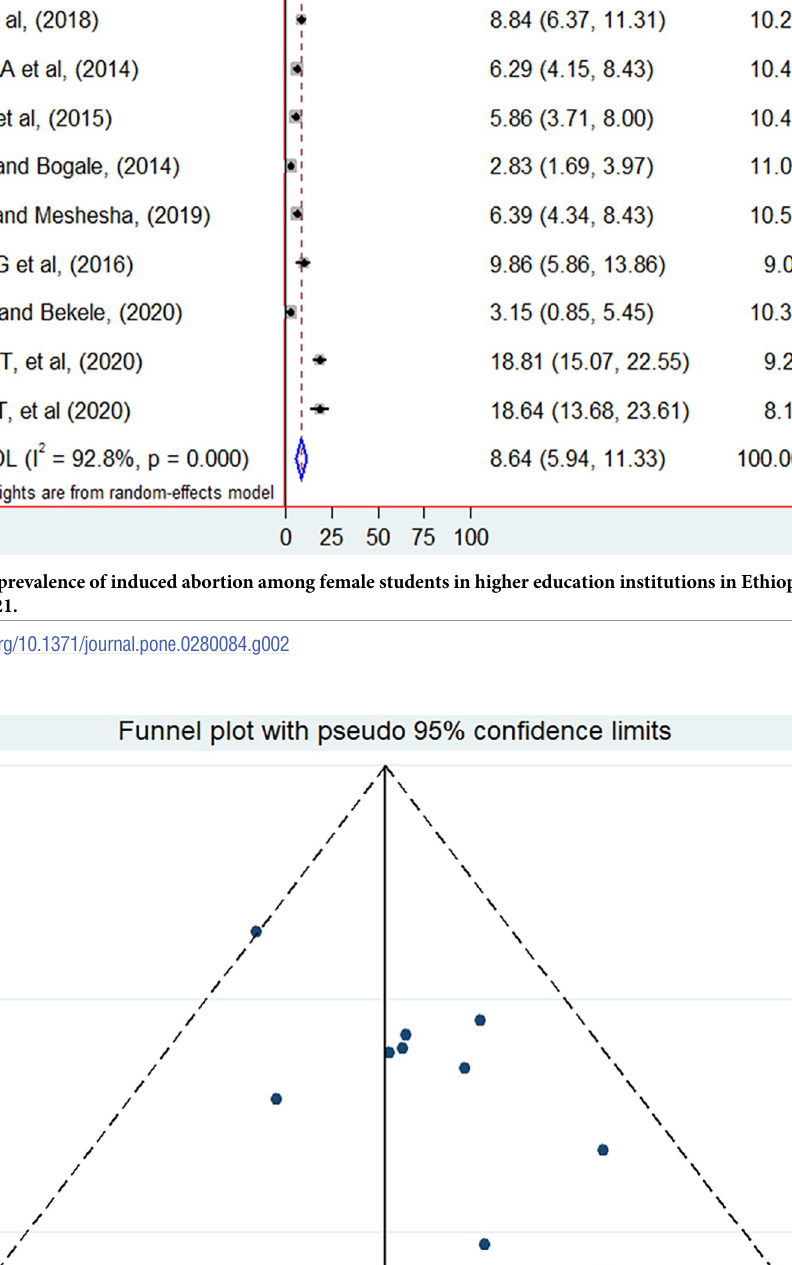
PLOS ONE | https://doi.org/10.1371/journal.pone.0280084 January 20,